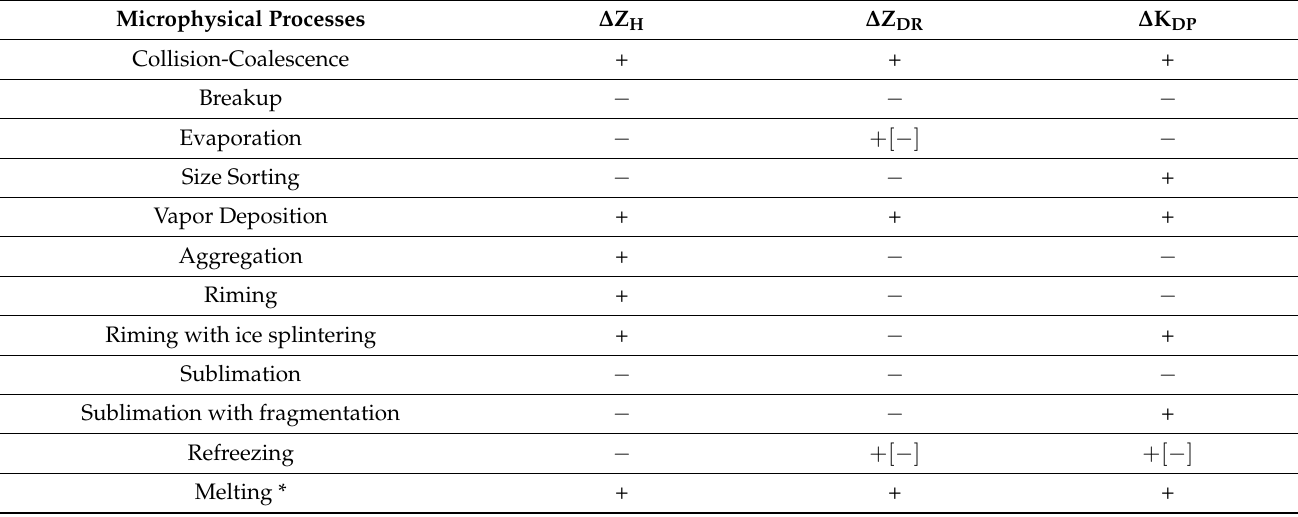
Table 1. Summary of the changes in the polarimetric radar variables towards the ground for different microphysical processes. A positive sign + indicates an increase in that radar variable between the top and bottom of the profile, whereas a negative sign indicates a decrease. The presence of a second sign in brackets [] indicates the possible variation. ∆ Z